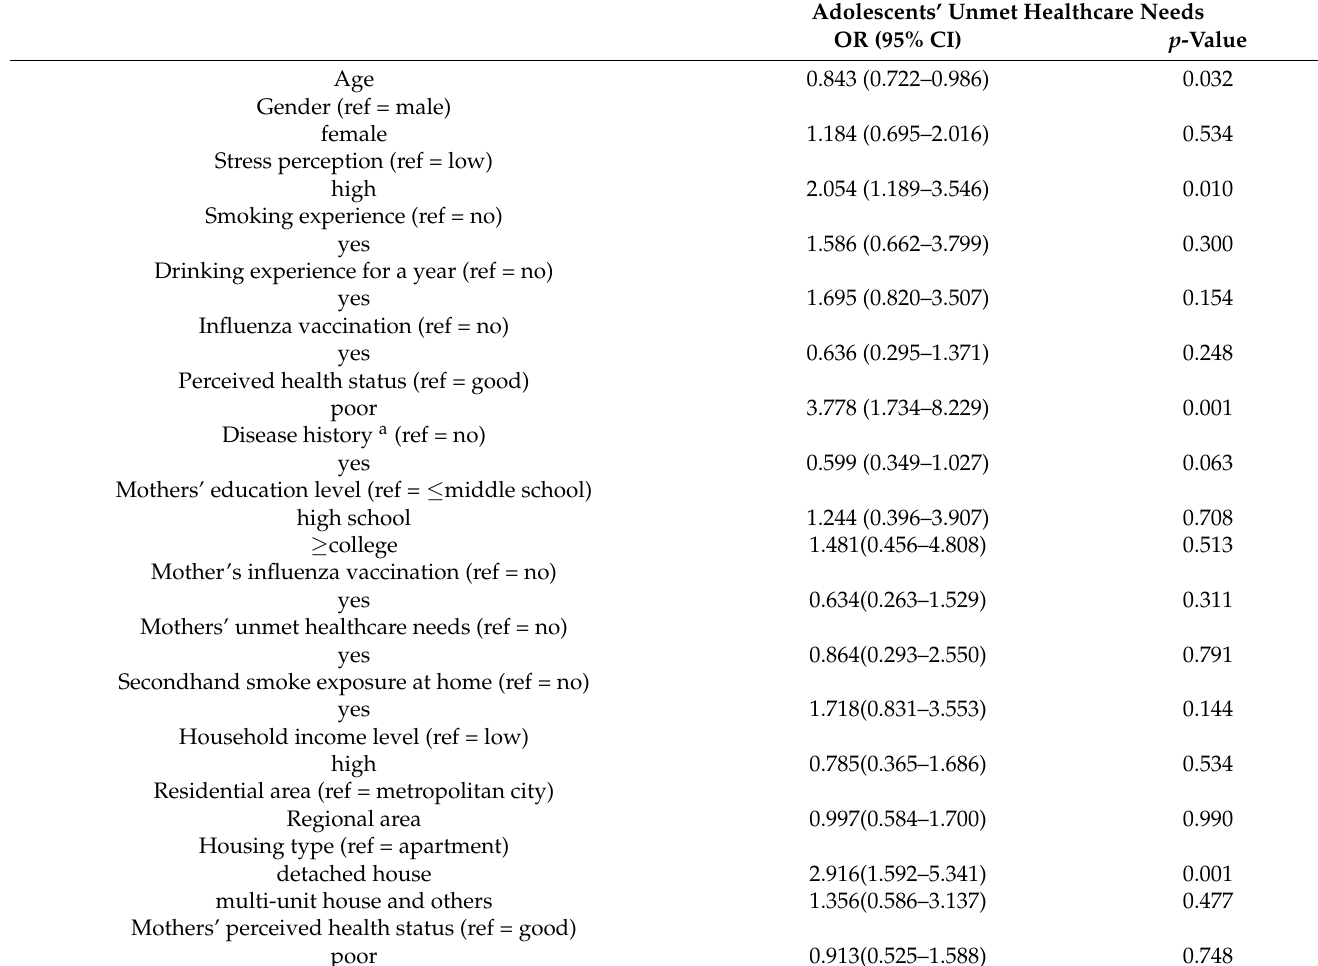
Table 2. Results of multiple logistic regression on unmet healthcare needs among adolescents.